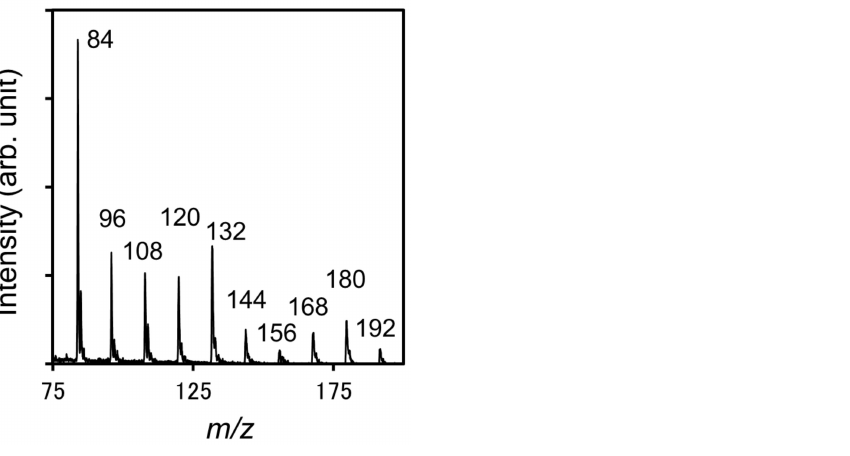
Figure 5. SALDI mass spectrum of CNWs without N-BP-Cl, measured at a laser fluence of 51 mJ/cm 2